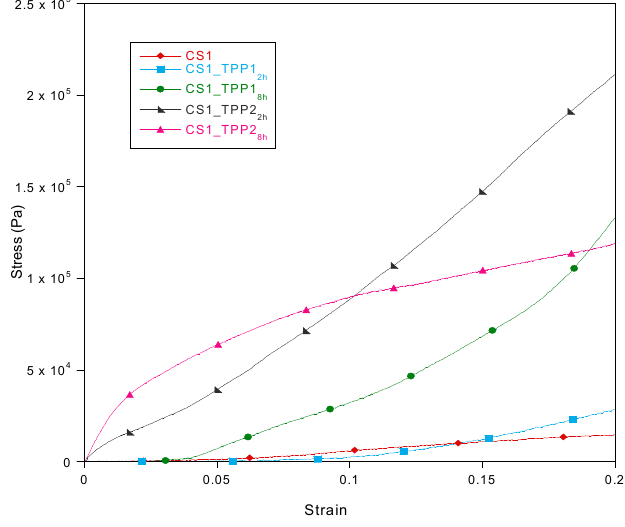
Figure 8. Stress–strain curves for the CS1 and CS1_TPP scaffolds.